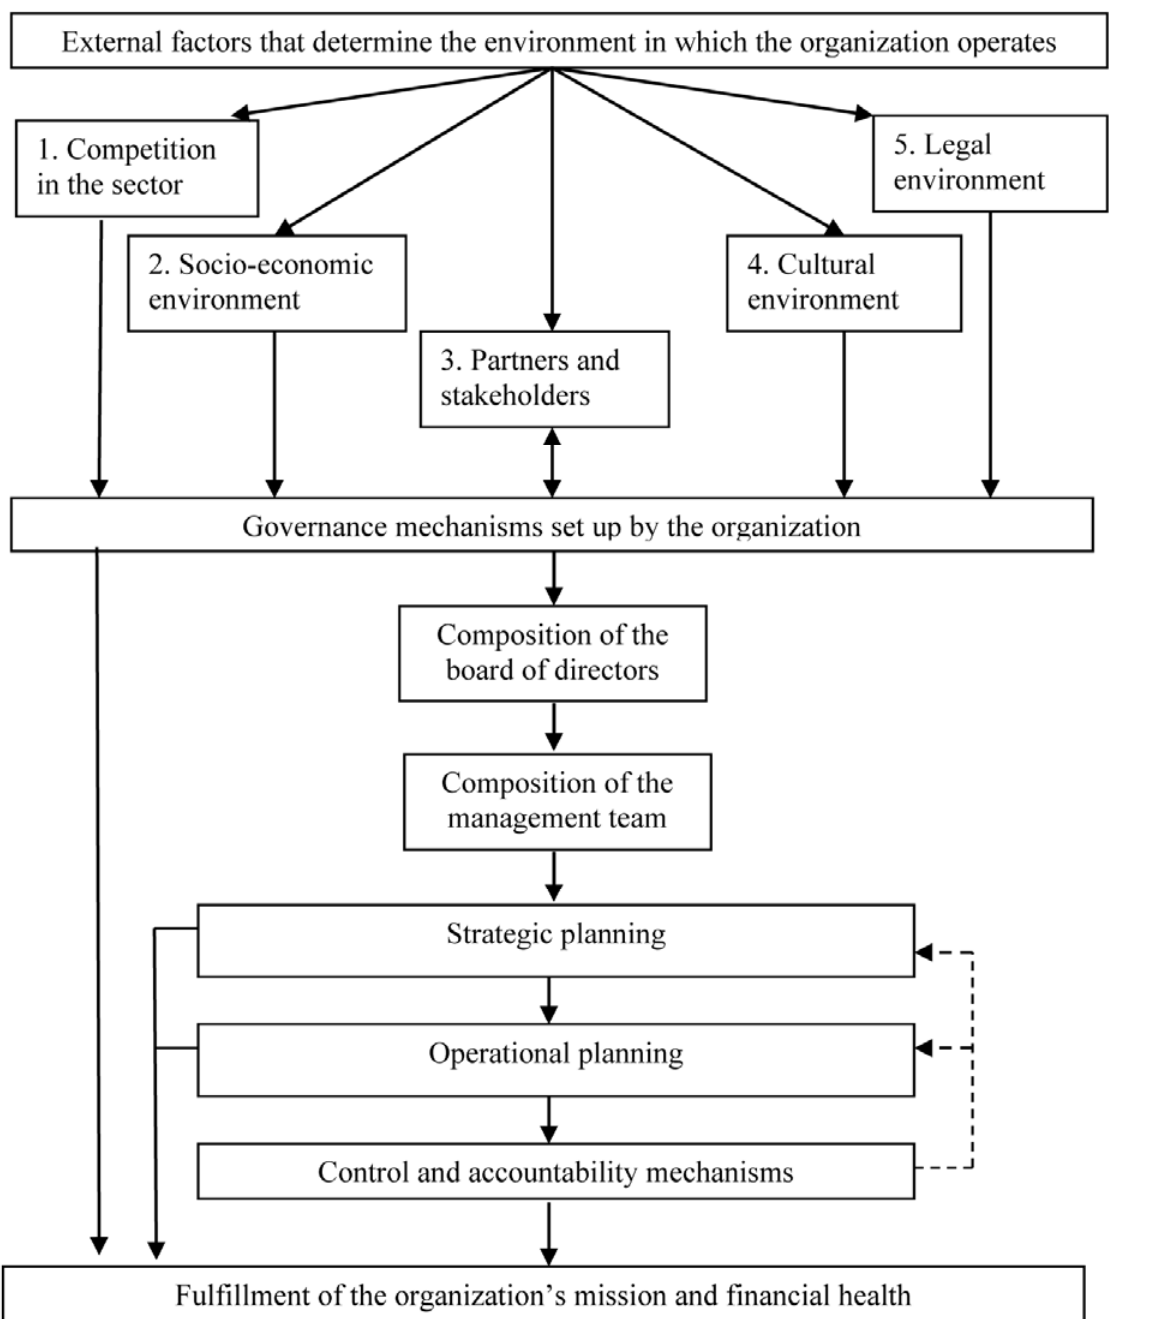
Figure 1. Governance framework based on dimensions that could impact on organizational and financial health in nonprofit organizations